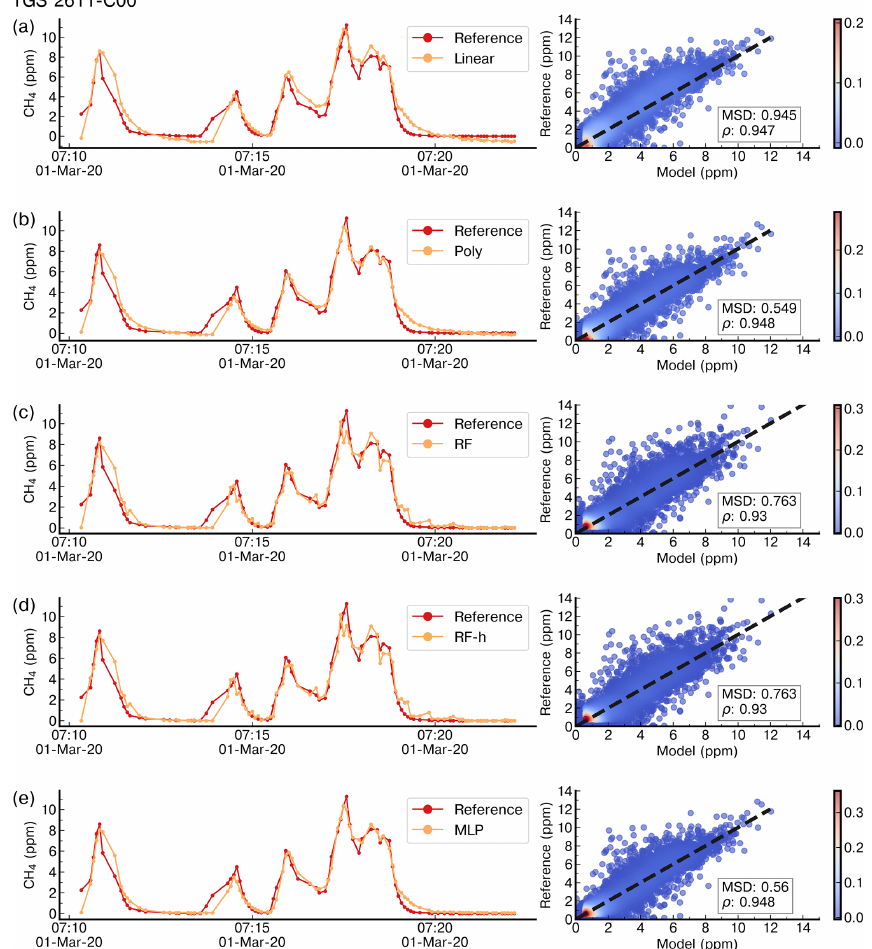
Figure 4. Example of reconstruction of the CRDS reference CH 4 signal on a time step of 5s for a few spikes in the test set by (a) a linear model, (b) a polynomial model, (c) a random forest model, (d) a random forest hybrid model and (e) a multilayer perceptron model trained with 70% of data and using as input data from the TGS 2611-C00 sensors only. The right panels show scatter plots between the reference CH 4 signal and the modeled outputs. The color code is the density of